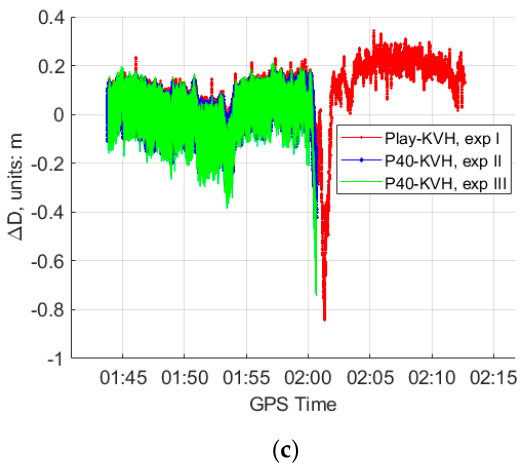
Figure 5. The position differences of the GNSS/IMU coupled solutions between the two smartphones (our program in a 15-state Kalman filter and the “KVH 1750” (IE software) in GNSS open-sky condition at experiment I, II and III. ( a ) Position differences in the North direction; ( b ) position differences in the East direction; ( c ) position differences in the Down direction.